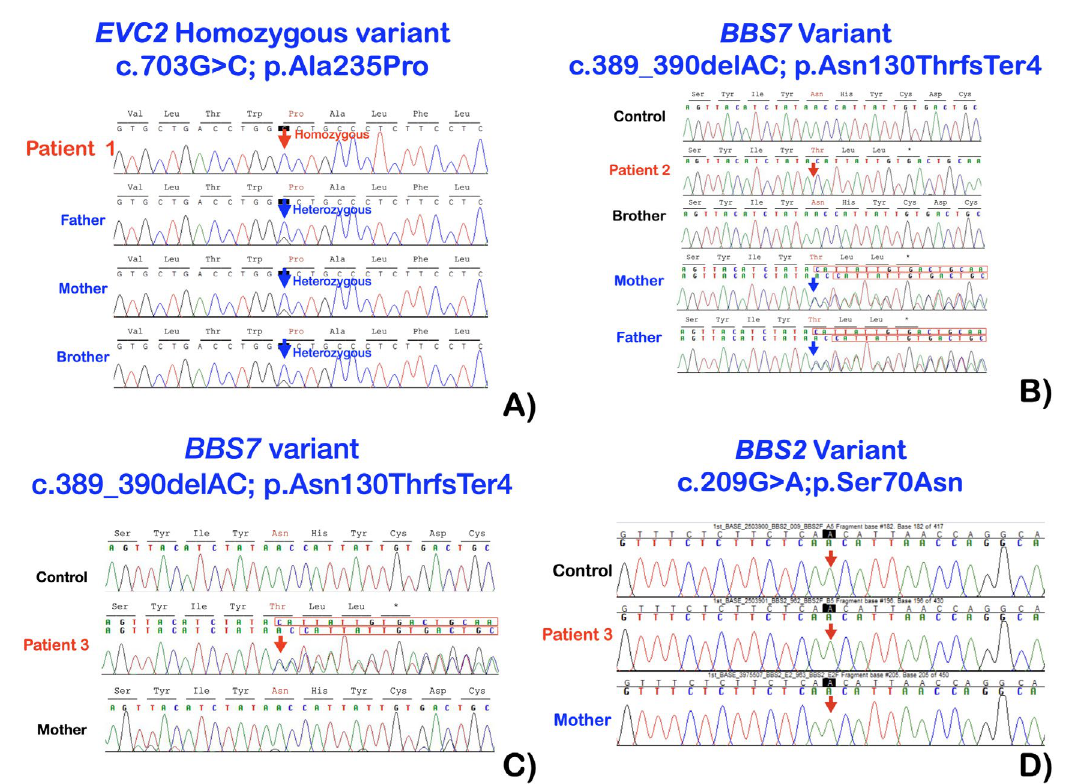
Figure 4. ( A ) Patient 1. Electropherograms showed a homozygous missense mutation in